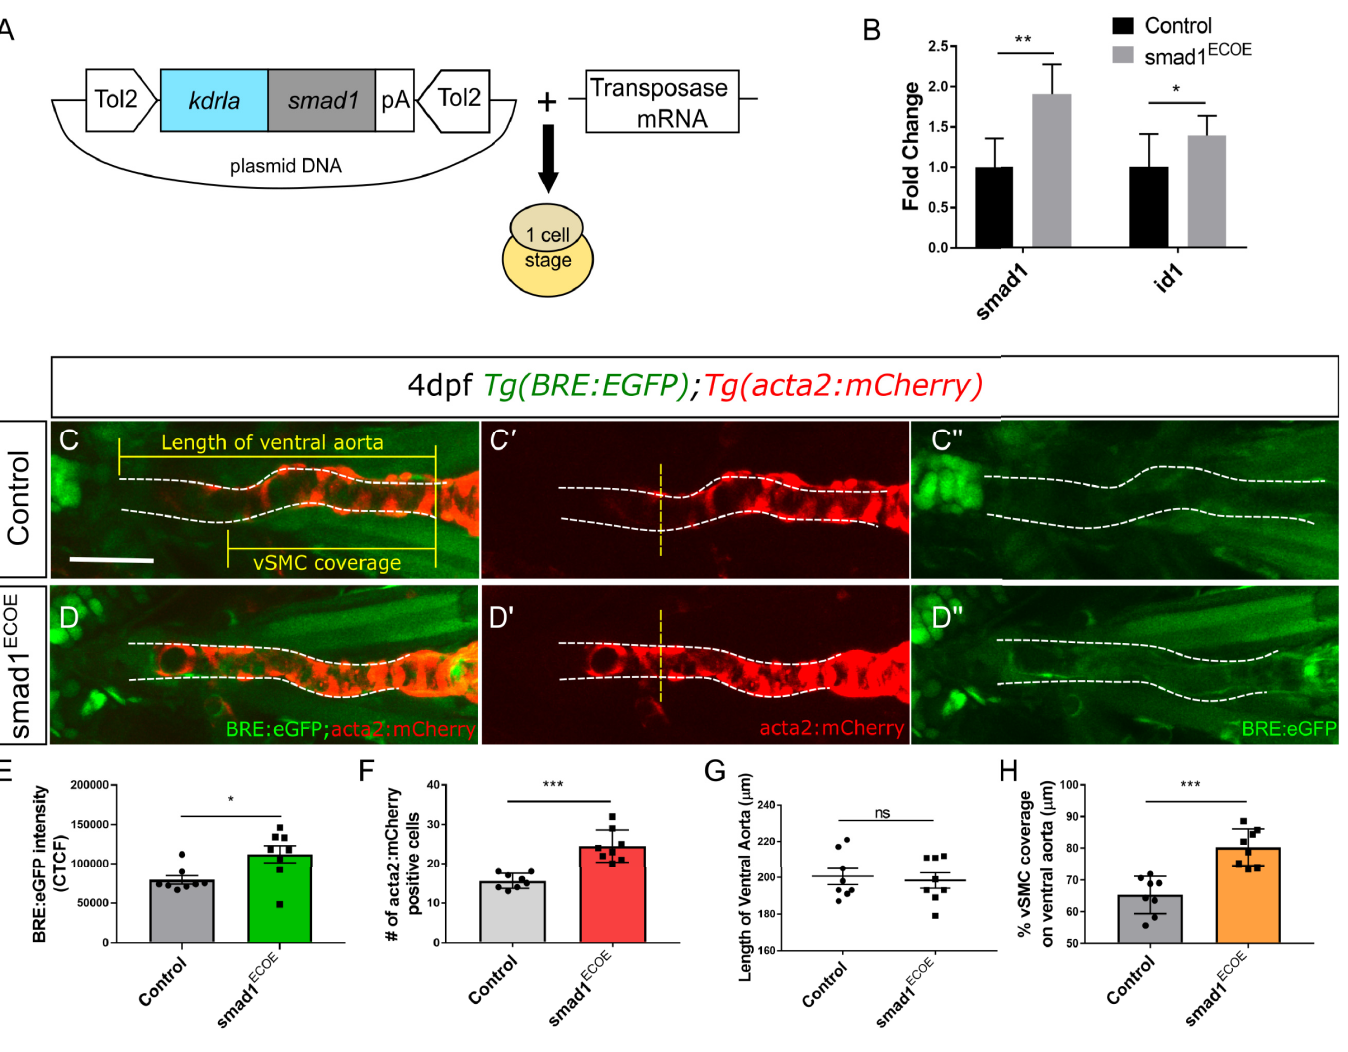
Fig 6. smad1 overexpression in endothelial cells results in increased vSMC coverage. A) Vector construct for overexpression of smad1 under the endothelial cell promoter kdrla . B) RT-qPCR fold change in smad1 and id-1 expression levels in endothelial specific smad1 overexpressing embryos (smad1 ECOE ) embryos at 4 dpf (n = 3). RT-qPCR data show the mean ± SEM, Student’s two-tailed t-test � p < 0.05, n, number of biological replicates. C–D) Representative orthogonal projections of ventral views of 4 dpf Tg(BRE : EGFP) ; Tg(acta2 : mCherry) embryos. Control embryos (C-C”) and smad1 ECOE embryos (D-D”) showing endothelial BRE:EGFP and vSMC acta2:mCherry expression in the ventral aorta (VA) and pharyngeal arch arteries (PAA). E) Quantification of green fluorescent marker ( BRE : EGFP ) along the VA, highlighted within the yellow region in C” and D”, as corrected total cell fluorescence (CTCF). F) Quantification of acta2 positive cell number on VA, within area outlined in C and D. Number of acta2 positive cells is significantly increased in smad1 ECOE embryos. G) Quantification of length of VA, within area outlined in C and D. H) Quantification of the percent vSMC coverage of ventral aorta. For each quantification, N = 3, smad1 ECOE embryos n = 8, Control n = 8, Student’s two-tailed t-test, � - ��� p < 0.01–0.0001 as compared to control. Error bars = SEM, Scale bar represents 50 μ